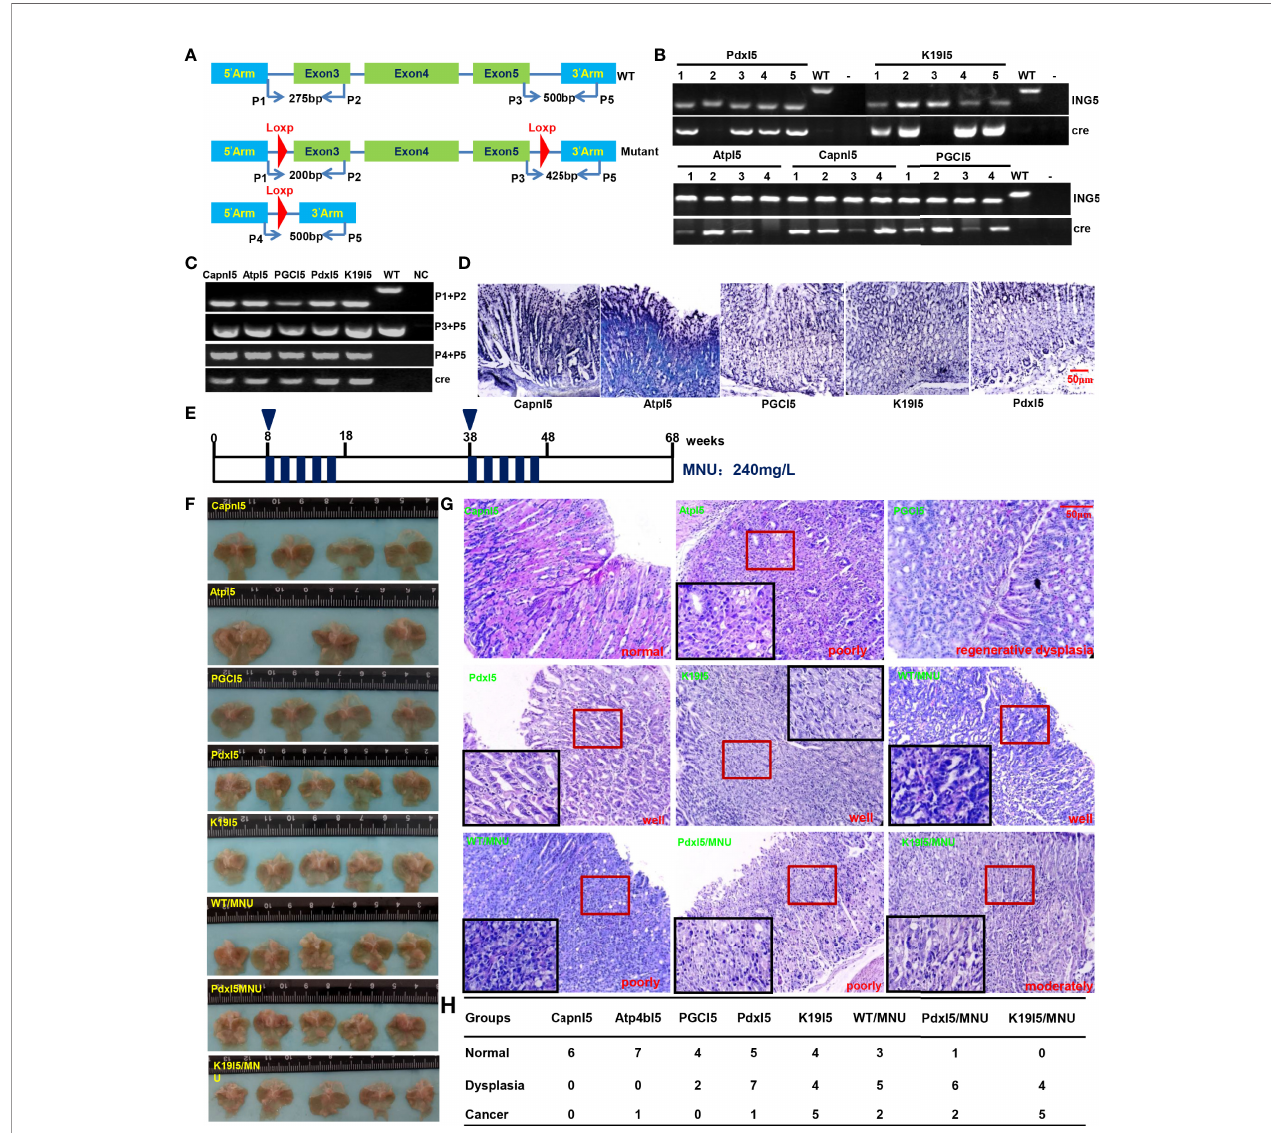
FIGURE 6 | The effects of conditional ING5 knockout on gastric carcinogenesis PCR primers were designed (A) and used for PCR of tail (B) DNA. We performed tube (C) and in situ (D) PCR ampli fi cation targeting mutant and deleted ING5 using the stomach samples of Capn8-cre/ING5 f/f (CapnI5), Atp4b-cre/ING5 f/f (AtpI5), PGC-cre/ING f/f (PGCI5), Pdx1-cre/ING5 f/f (PdxI5), and K19-cre/ING f/f (K19I5) and. MNU was orally administered into these wild-type and conditional knockout mice in accordance with the schedule (E) . The stomach of wild-type (WT) and knockout (KO) mice was grossly (F) and histologically (G) observed with or without exposure to MNU (240 mg/L) until 68 weeks. The histological fi ndings on the gastric lesions are summarized in (H) .P, primer; NC, negative